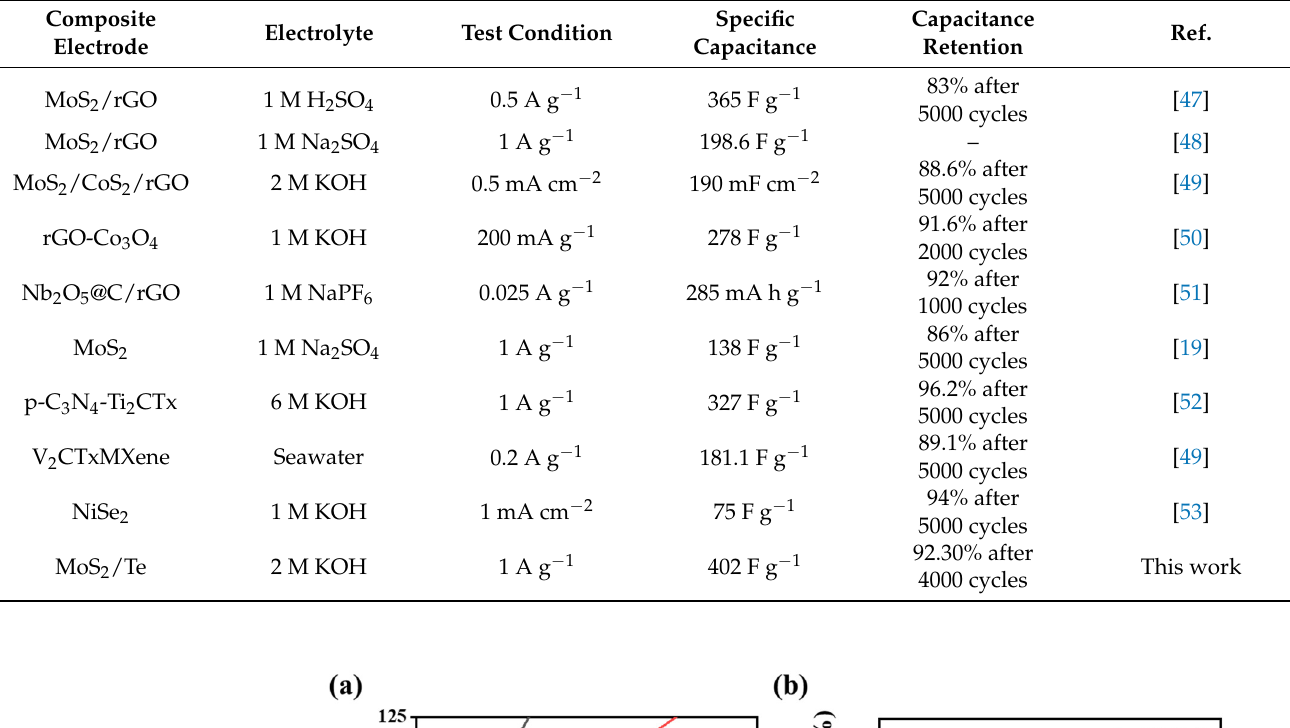
Table 2. Comparison of recent composite electrodes based on electrolyte, test conditions, specific capacitance, and capaci- tance retention.